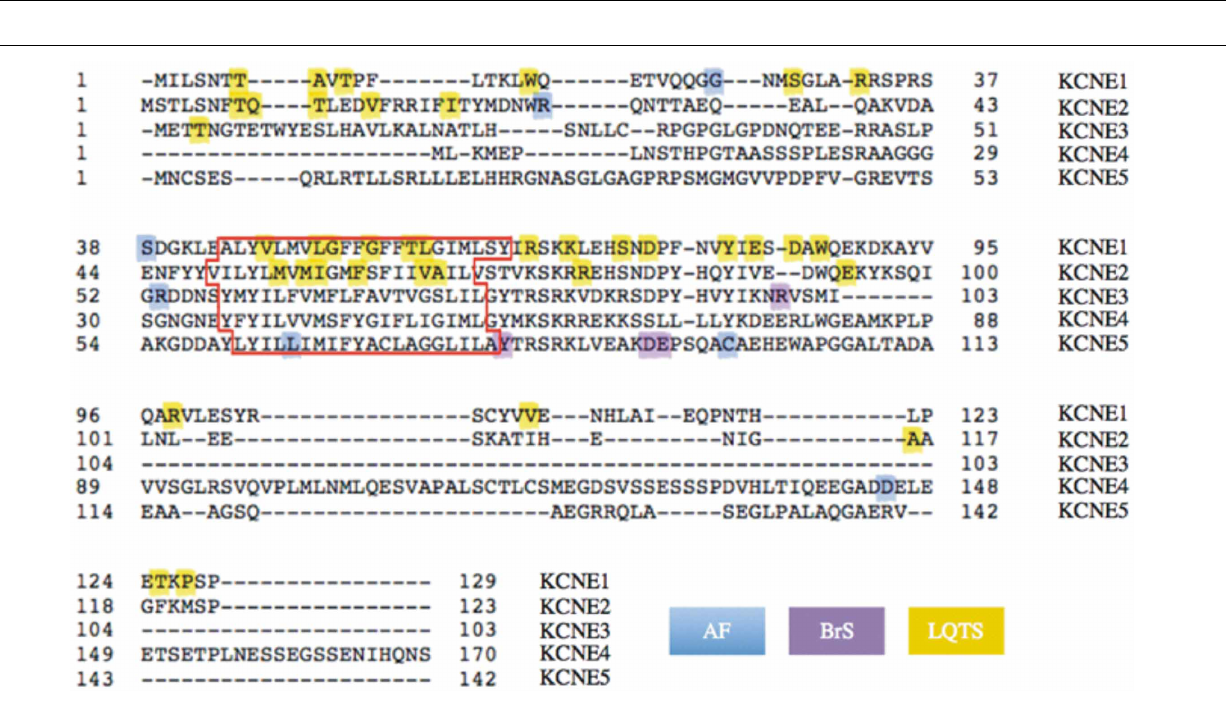
FIGURE 2 | Human KCNE1-KCNE5 protein sequence alignments and gene variants. Image of aligned sequences generated using http://www.uniprot.org/align. Colors highlight inherited or sporadic non-synonymous mutations or polymorphisms resulting in single amino acid